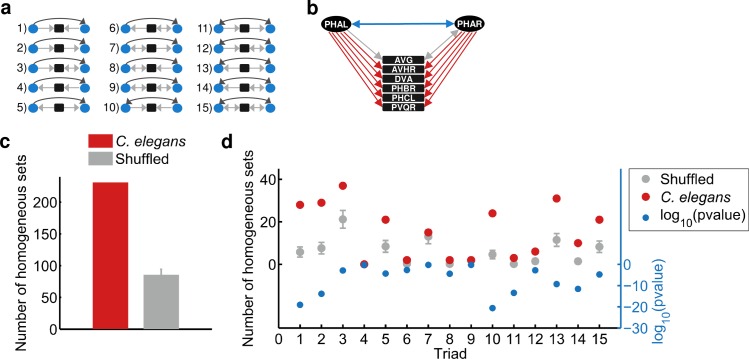
The C. elegans connectome is enriched with connected homogeneous common neighbor sets.(a) All possible connected triads when preserving the identity of connected X and Y pair of neurons and their mutual neighbors (Z’s). In triads 1–9, X and Y are connected uni-directionally, and in triads 10–15 X and Y are connected bi-directionally. (b) An example of a homogenous set of common neighbors where PHAL and PHAR are the X and Y neurons connected bi-directionally. Both PHAL and PHAR connect to multiple downstream neurons forming mainly type 10 triads. (c) The neural network of C. elegans is significantly enriched with homogenous sets when comparing to sets generated randomly by shuffling the existing sets (Hyper-geometric test p-value threshold is set to 0.05; p<10–50 for connected sets with five or more common neighbors). (d) Results of the same analysis shown in panel (c), but here the connected sets are grouped according to their specific type (according to panel (a)). The positive (left) y-axis represents the number of homogeneous sets in shuffled (grey) and real (red) sets. The negative (right, blue) y-axis depicts the significance of the difference between the shuffled and the real sets (z-test; after Bonferroni correction).